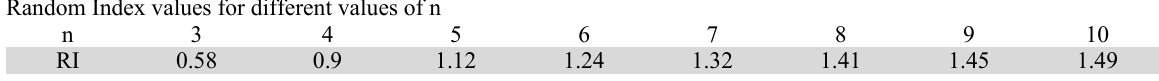
Random Index values for different values of n